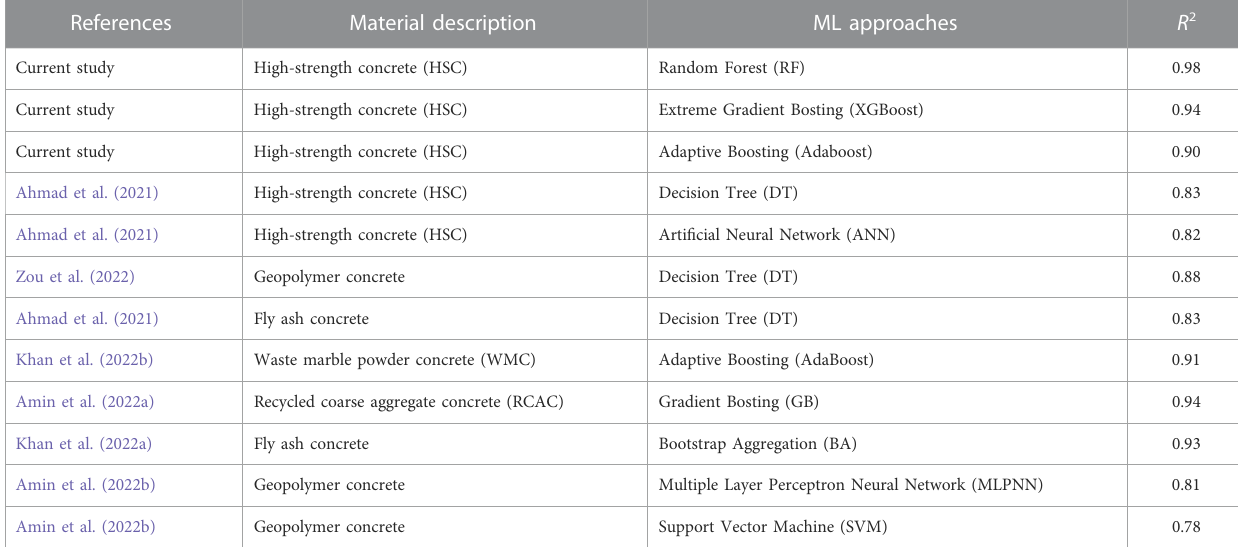
TABLE 2 Summary of prediction models in the current study and in the